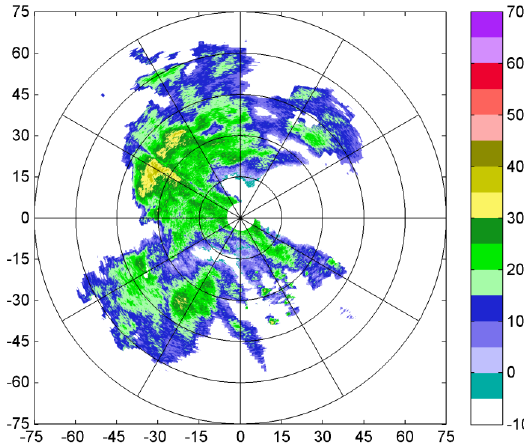
Figure 15. Original reflectivity at X-band for the stratiform cloud on 16 June 2015.